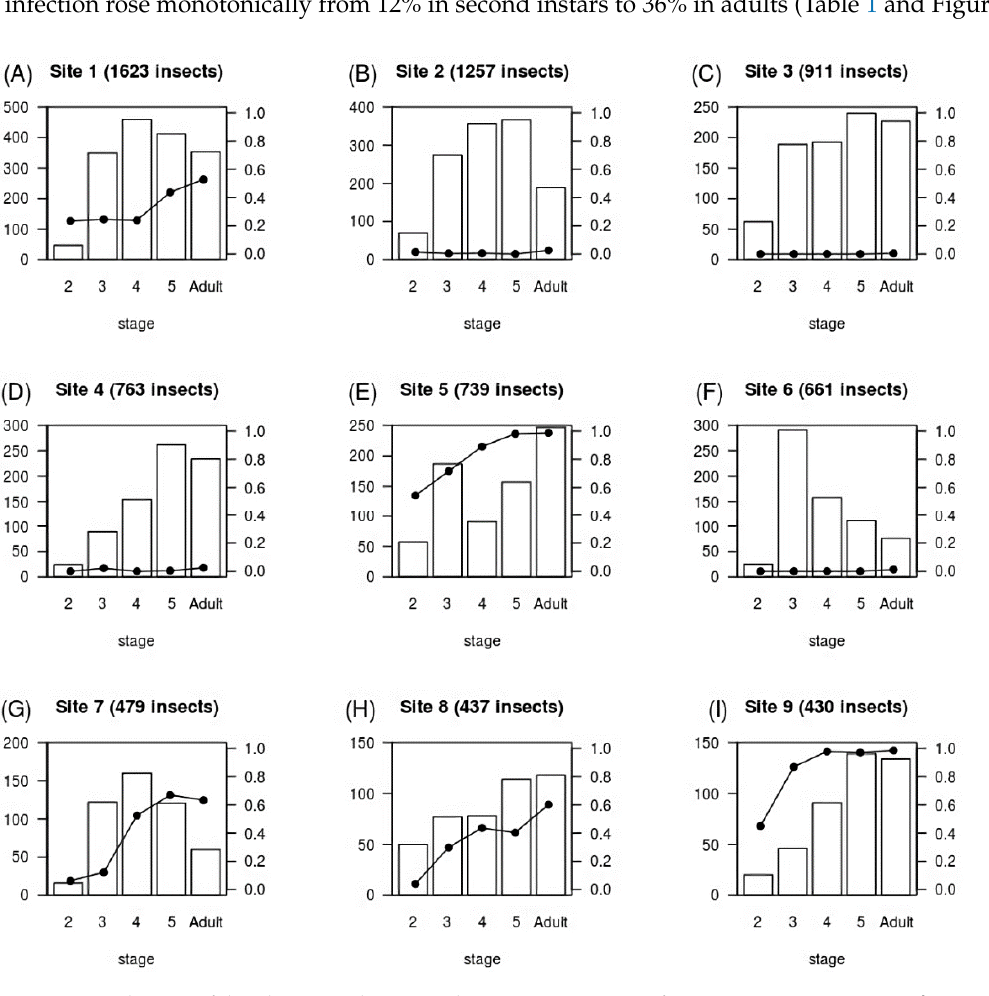
Figure 2. Distribution of developmental stage and Trypanosoma cruzi infection status in Triatoma infestans from nine households in Arequipa, Peru. Shown are the nine infected sites with the largest number of captured insects. White and black bars and left vertical axis labels: total number of insects. Black circles and right vertical axis labels: fraction of insects with T. cruzi . Table 1. Trypanosoma cruzi infection status by developmental stage, for 15,252 triatomines captured in 188 infected colonies in Arequipa, Peru.